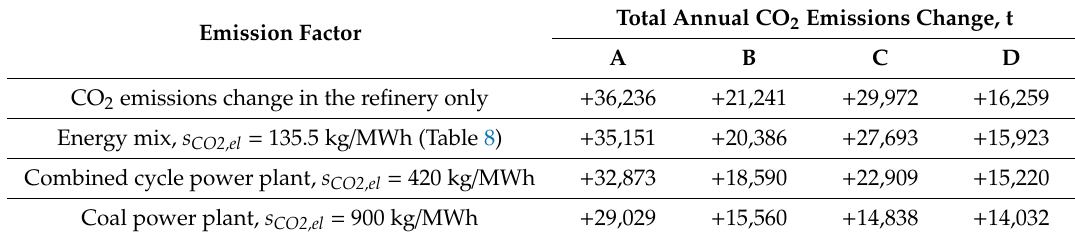
Table 13. Impact of electric energy production emissions factor on the total CO 2 balance in individual scenarios.